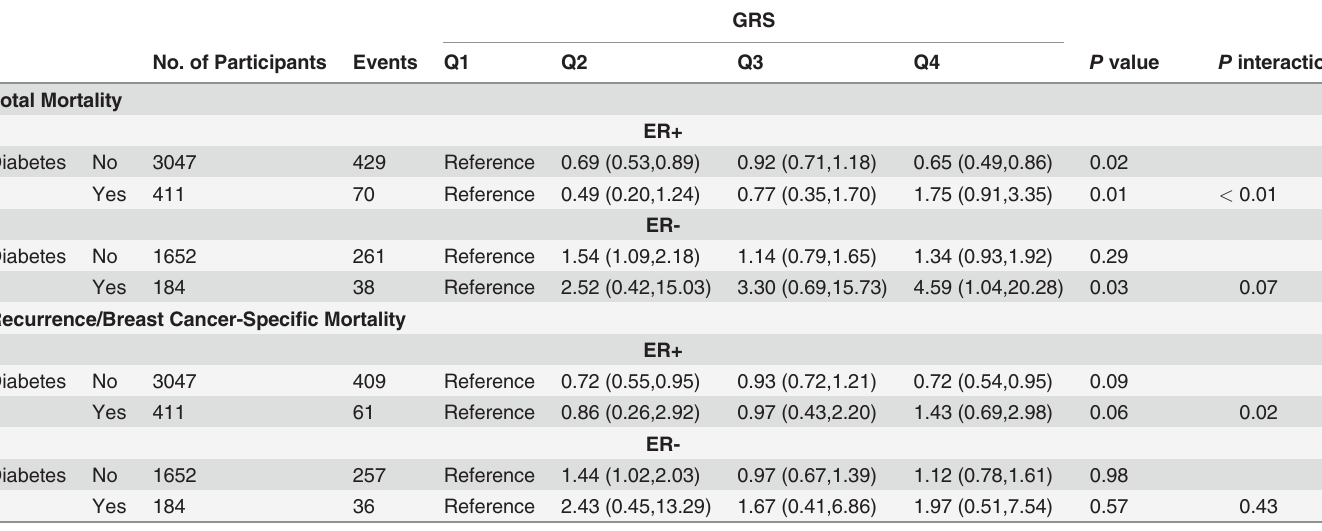
Table 4. Association of the diabetes Genetic Risk Score (GRS) with OS and DFS by ER status and diabetes